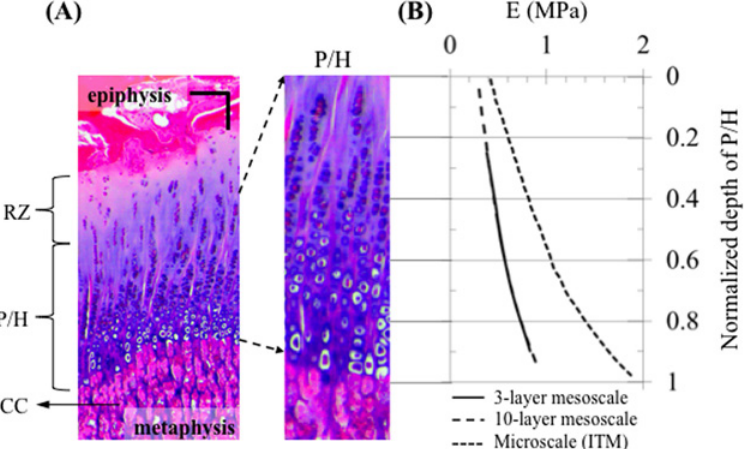
Fig 2. Determination of the elastic moduli of the growth plate utilized in the models. (A) Stained histological slice (haematoxylin and eosin) of a 4-month old bovine growth plate; chondrocytes are dispersed in the reserve zone (RZ) and are stacked in tubes (chondrons) extending from the zone of proliferation (P) through the zones of maturation and hypertrophy (H). The walls of the chondron tubes (interterritorial matrix) become increasingly calcified toward the metaphyseal side. Following chondrocyte death, the walls of tubes or bars of calcified cartilage (CC) matrix form the scaffolding upon which bone is laid down (primary spongiosa); scale bar = 100 μ m. (B) Distribution of the elastic modulus of the P/H zone (3-layer mesoscale and 10-layer mesocale models) and interterritorial matrix (ITM) (microscale